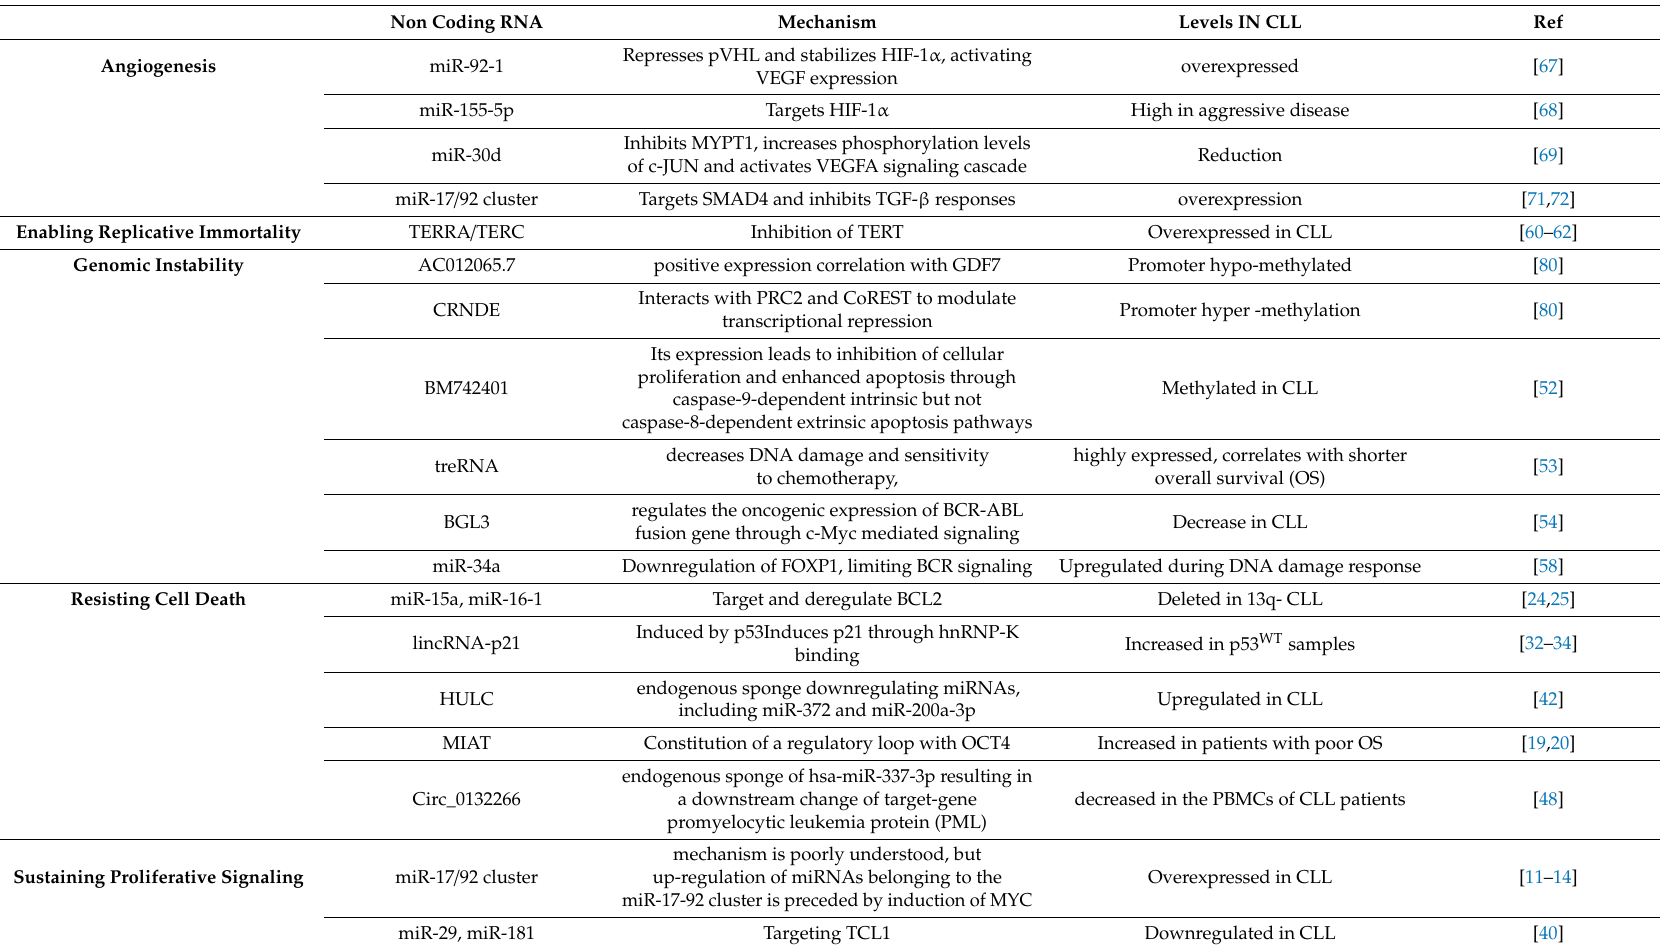
Table 1. ncRNAs associated to Hallmarks of Cancer in